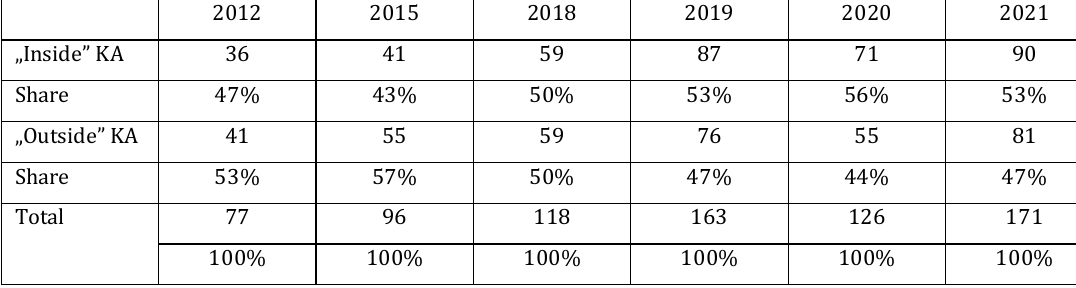
Fig. 6. Number and structure of decisions on building conditions in Łódź between 2012–2020 (Source: own study based on the LDB) Table 1. Share of developer investments identified "inside" Łódź in selected